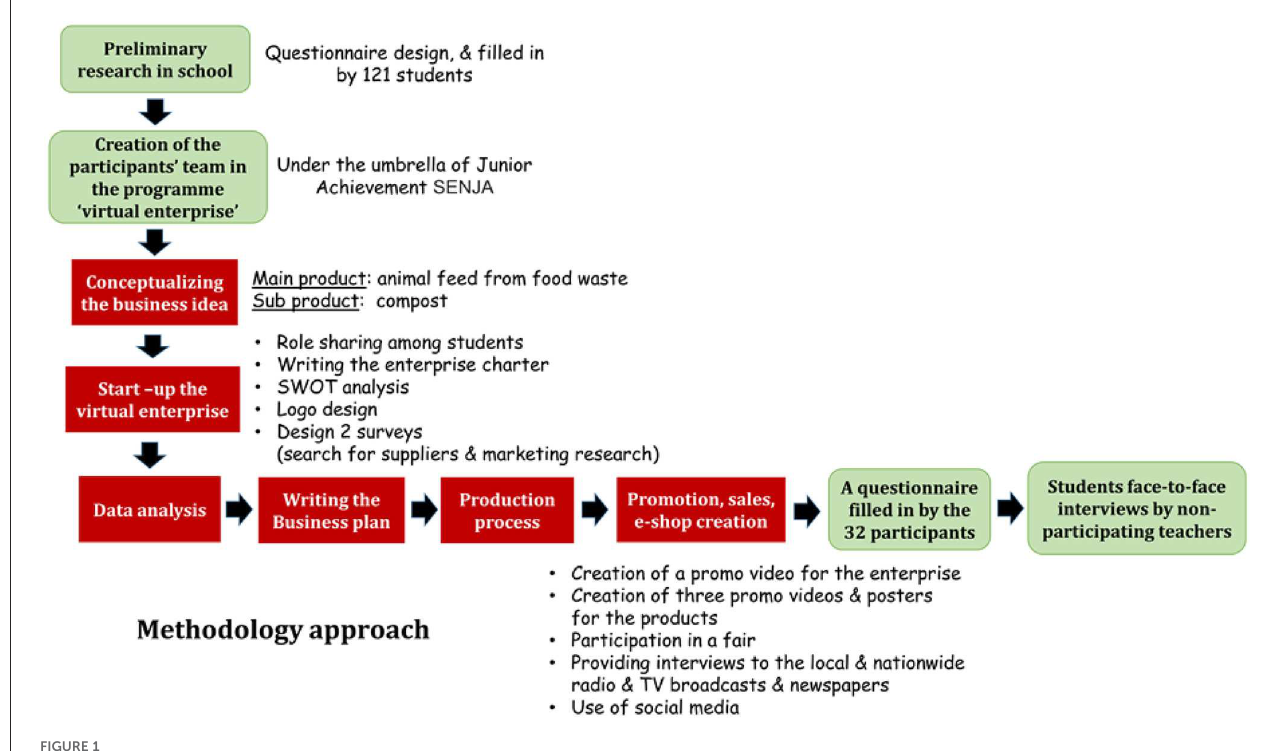
FIGURE1 The methodology